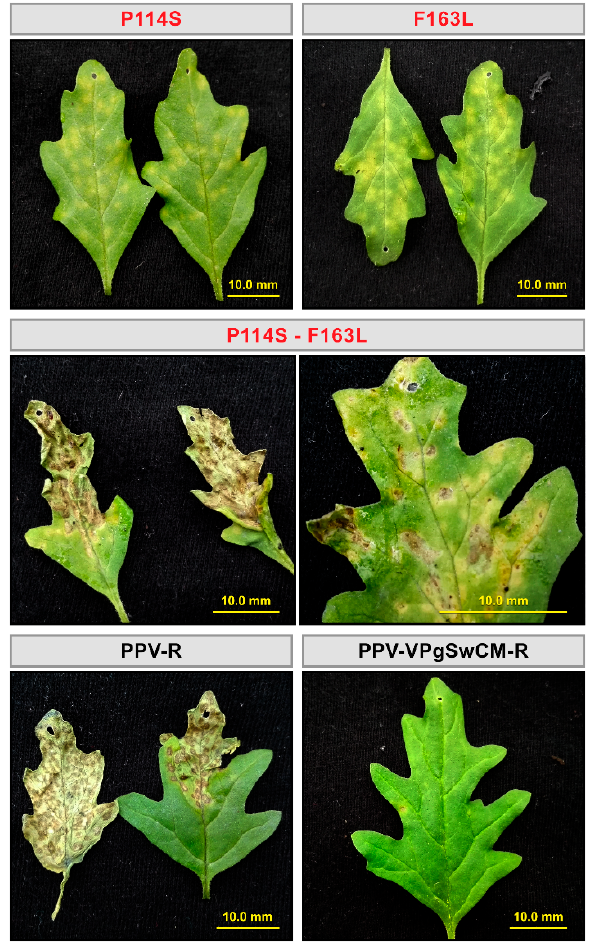
Figure 4. Effect of VPg mutations on Chenopodium foetidum infection by Plum pox virus (PPV). C. foetidum leaves were inoculated by hand rubbing with leaf extracts of Nicotiana clevelandii plants, previously infected with two independent clones of pICPPV-VPgSwCM-R, variants of this chimeric clone mutated as indicated, or pICPPV-NK-lGFP (PPV-R isolate). Eight plants (three leaves per plant) per construct (four per clone) were inoculated. Representative images taken at 12 dpi under visible light are shown. Bar, 10.0 mm.